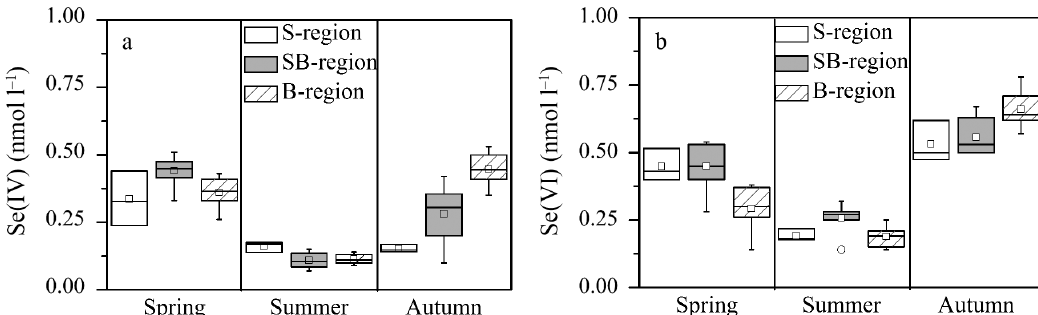
Fig. 3. Box plots of (a) Se(IV) and (b) Se(VI) concentrations in seaweed monoculture (S-region), seaweed-bivalve polyculture (SB-region) and bivalve monoculture (B-region) in spring, summer and autumn of 2013. The ends of the box and the ends of the whiskers, and the line across the box represent the 25th and 75th percentiles, the 1st and 99th percentiles and the median, respectively; the open square inside the box indicates the mean value. A circle represents an